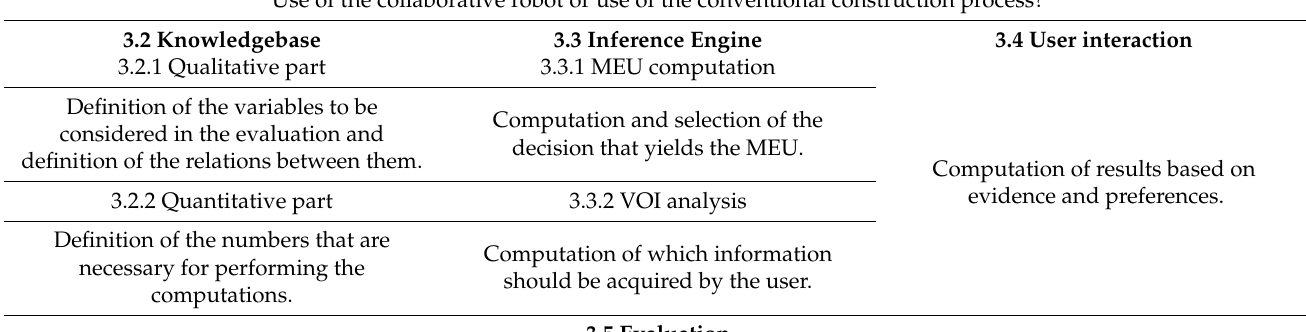
Table 1. Design guideline based on